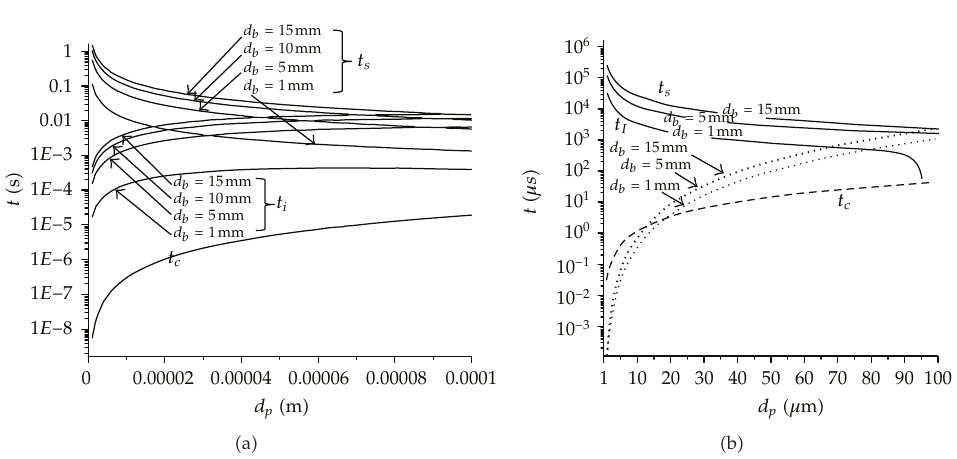
Figure 2: Relationship of the Inclusion Diameter to the collision, sliding and induction times. (cid:4) a (cid:5) t i calculated using the Nguyen’s equation and (cid:4) b (cid:5) t i reported by Zhang and Taniguchi (cid:6) 13 (cid:7) .